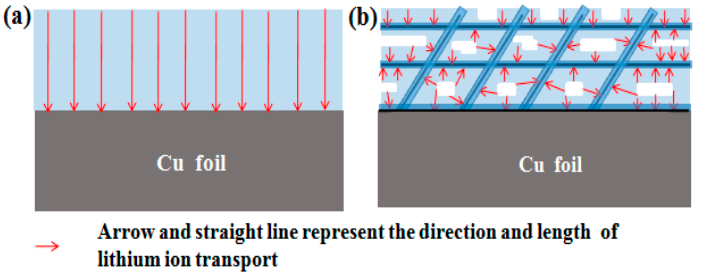
Figure 4. ( a , b ) Schematic diagram of the lithium ion diffusion in pure Si film and CSNEFs, respec-